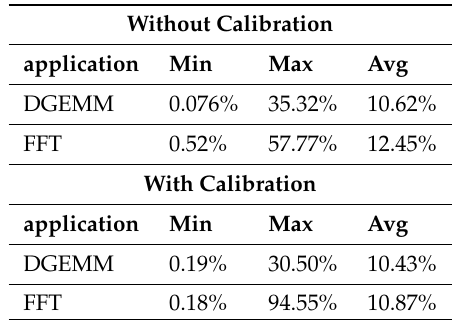
Table 4. Percentage error of dynamic energy consumption by Nvidia K40c GPU with and without calibration and HCLWattsUp on